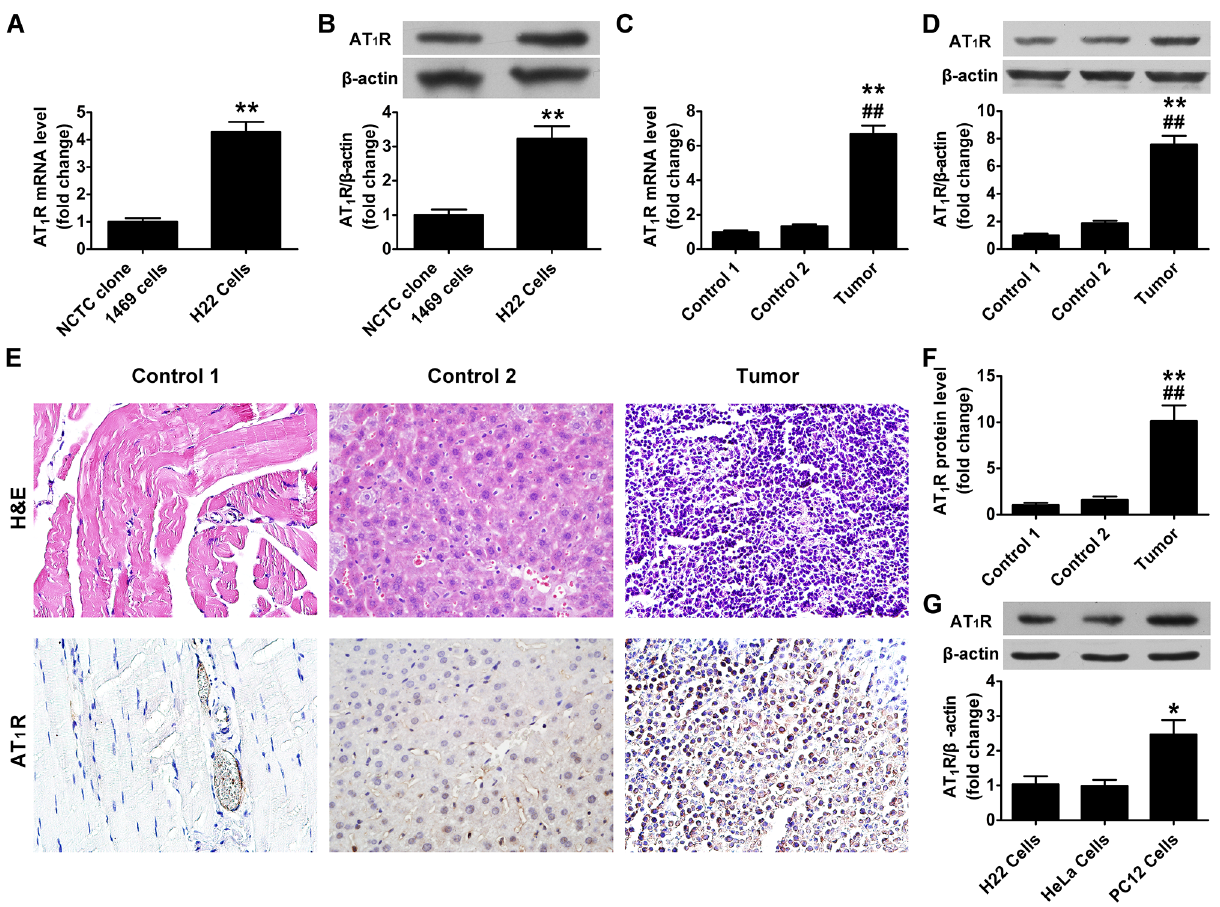
Figure 3. AT 1 R mRNA and protein expression. (A) Relative mRNA expression of AT 1 R in NCTC clone 1469 cells (normal hepatocytes) and H22 cells. ** P , 0.01 vs. NCTC clone 1469 cells. (B) Representative Western blot of AT 1 R and quantification of AT 1 R protein levels in NCTC clone 1469 cells and H22 cells. ** P , 0.01 vs. NCTC clone 1469 cells. (C) Relative mRNA expression of AT 1 R in the muscle of the opposite side (control 1), normal liver tissue (control 2) and hepatocellular carcinoma tissue. ** P , 0.01 vs. control 1. ## P , 0.01 vs. control 2. (D) Representative Western blot of AT 1 R and quantification of AT 1 R protein levels in control 1, control 2 and hepatocellular carcinoma tissue. ** P , 0.01 vs. control 1. ## P , 0.01 vs. control 2. (E) Representative hematoxylin and eosin staining (H&E) and immunohistochemical staining for AT 1 R (original magnification 400 6 ). (F) Quantification of AT 1 R protein levels in immunohistochemical staining. ** P , 0.01 vs. control 1. ## P , 0.01 vs. control 2. (G) Representative Western blot of AT 1 R and quantification of AT